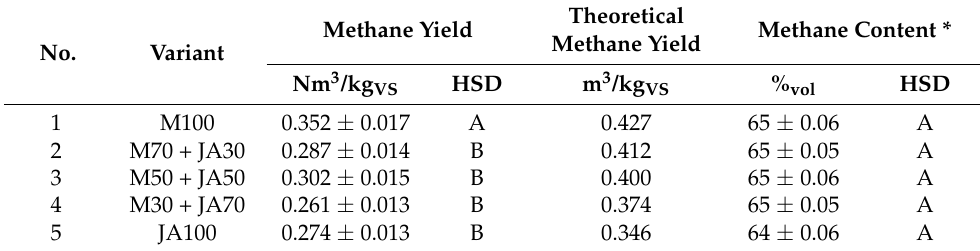
Table 7. Methane yield, theoretical methane yield and methane content in biogas after 35